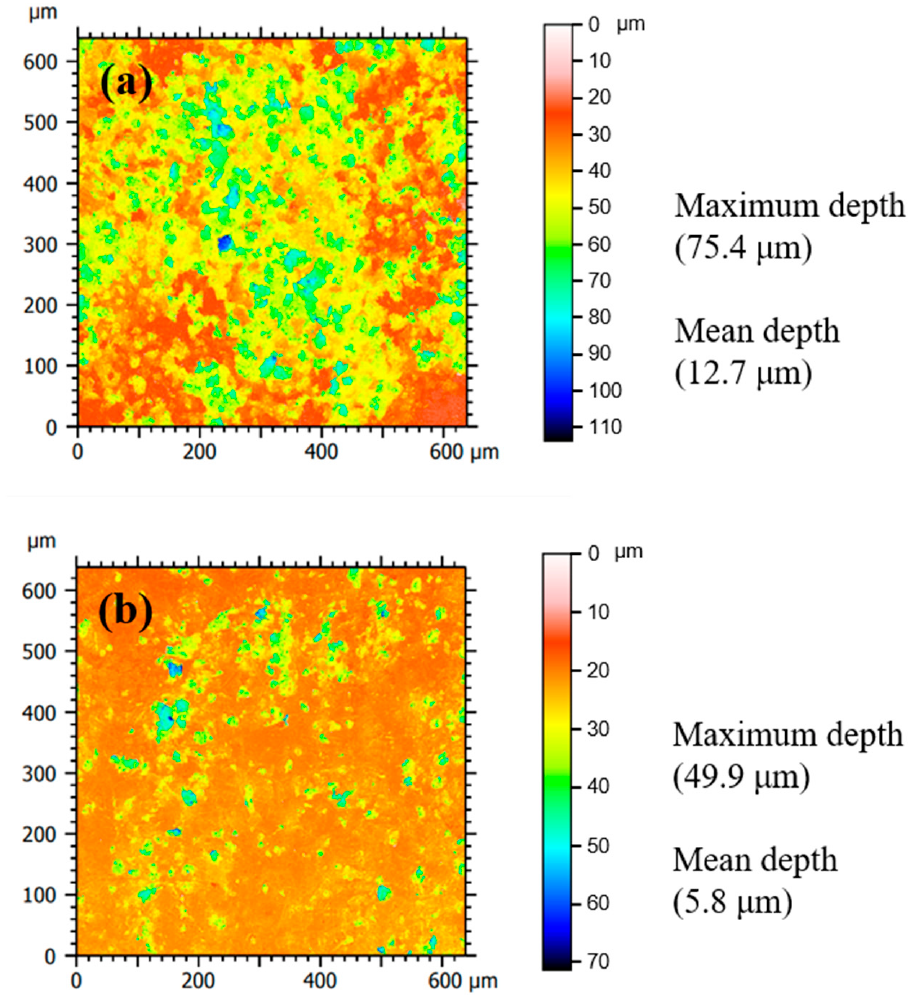
Figure 3. LSCM images showing the surface morphology of corroded STS specimens after immersion in 1 M HCl solution at 298 K: ( a ) uninhibited and ( b ) the inhibited specimens by 0.75 g/L of tea tree extract.